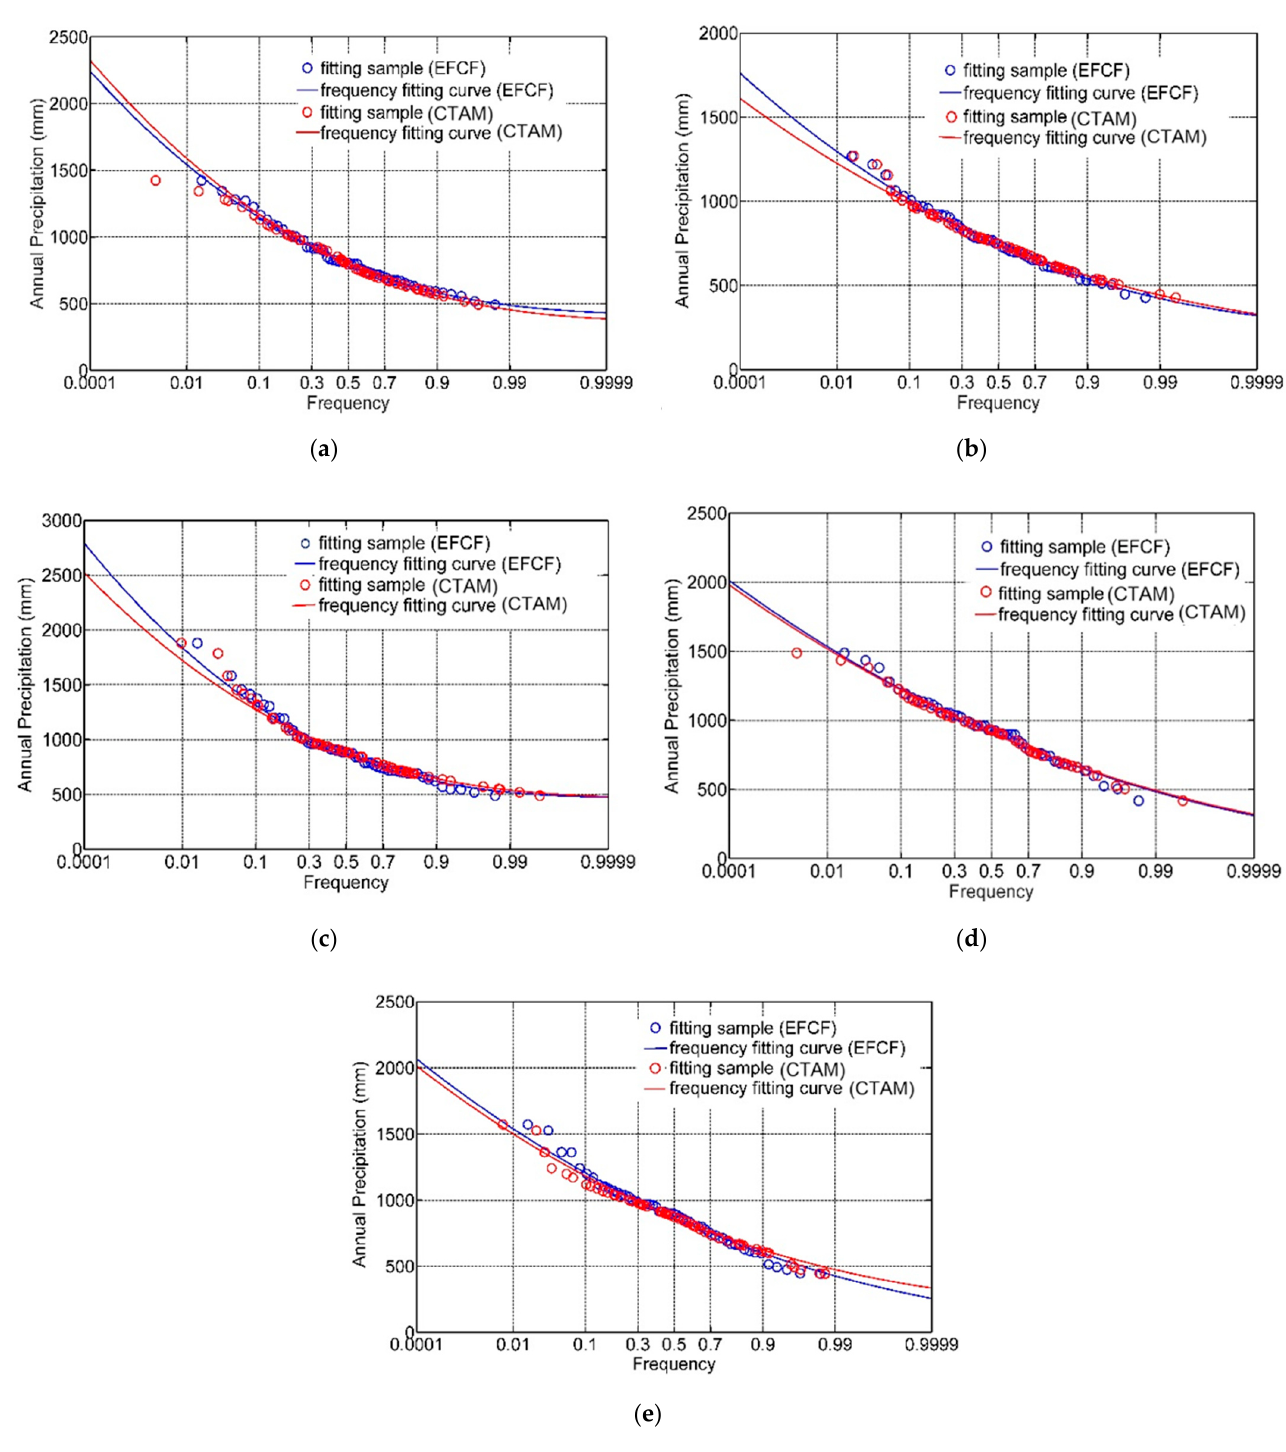
Figure 3. Frequency distribution fitting curve of annual precipitation in northern Anhui province, China. ( a ) Guoyangzha Station; ( b ) Dangshan Station; ( c ) Linquan Station; ( d ) Mohekou Station; and ( e ) Xifeihezha Station.